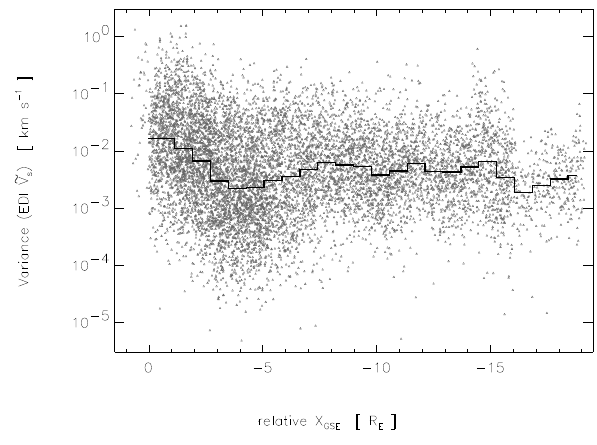
Fig. 8. Variances in ˜ V s for the same 10-min intervals as in Fig. 7, as a function of the distance along the GSE x-axis from the dayside polar cap boundary